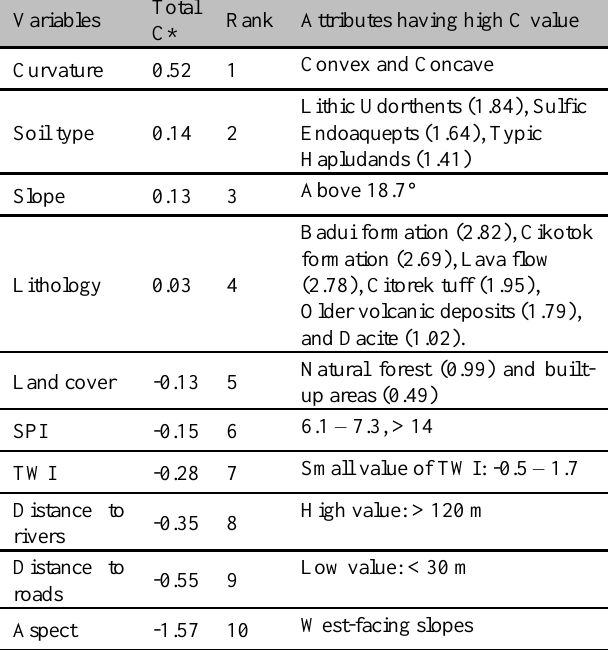
Table 1 Landslide variables studied and their spatial association with landslide events as judged by a high total C value. Slope gradient, aspect, and terrain curvature were derived from the DEM. The calculated slope gradient (°) was classified into nine classes using natural breaks. Slope aspect was expressed in nine classes of flat (-1), and other eight directions at an interval of 45°. Overall curvature (both profile and cross-section) values were classified into 9 classes using natural breaks. Stream